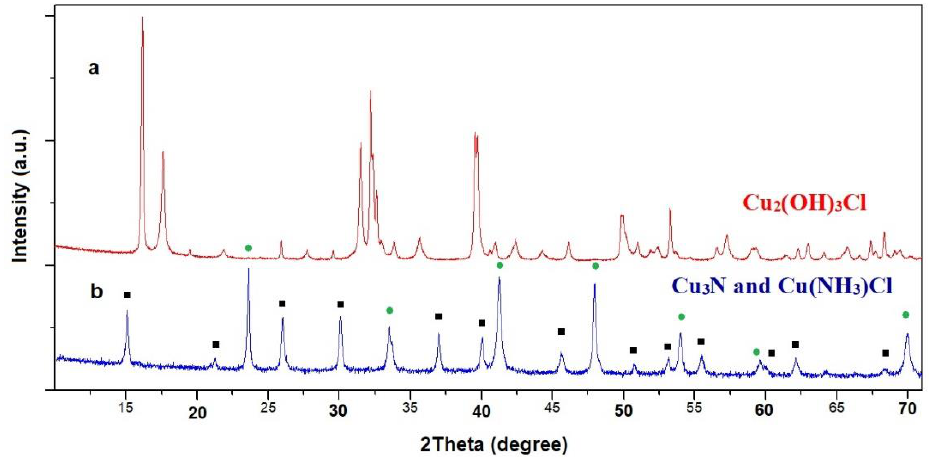
Figure 3. PXD patterns of ( a ) sample A as prepared and ( b ) sample A after heating in NH 3 atmos- phere at 300  C ( 1b ). Sample A could be indexed as single-phase atacamite, while peaks in the pattern from sample 1b could be identified as Cu 3 N ( ■ ) and Cu(NH 3 )Cl ( ●